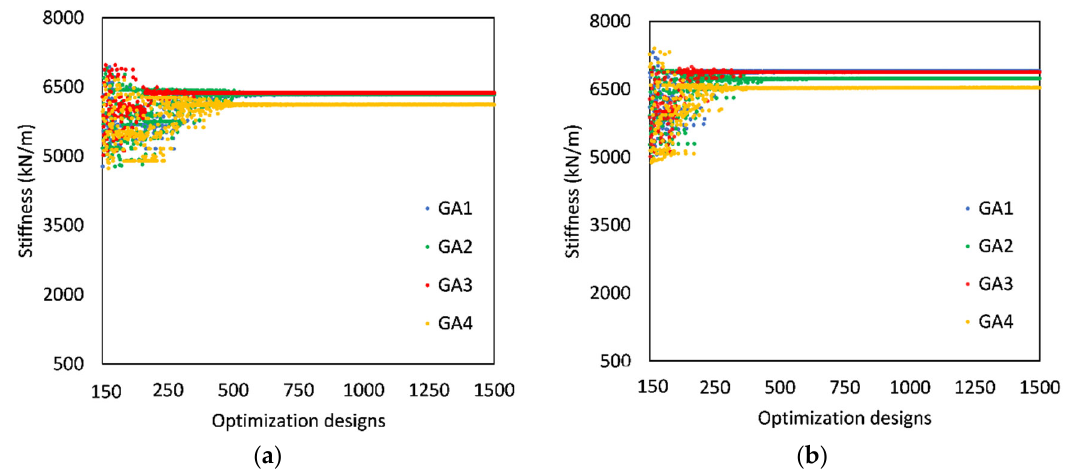
Figure 18. Variation of the optimal values of numerical parameter K1: ( a ) unloaded vehicle; ( b ) loaded vehicle.